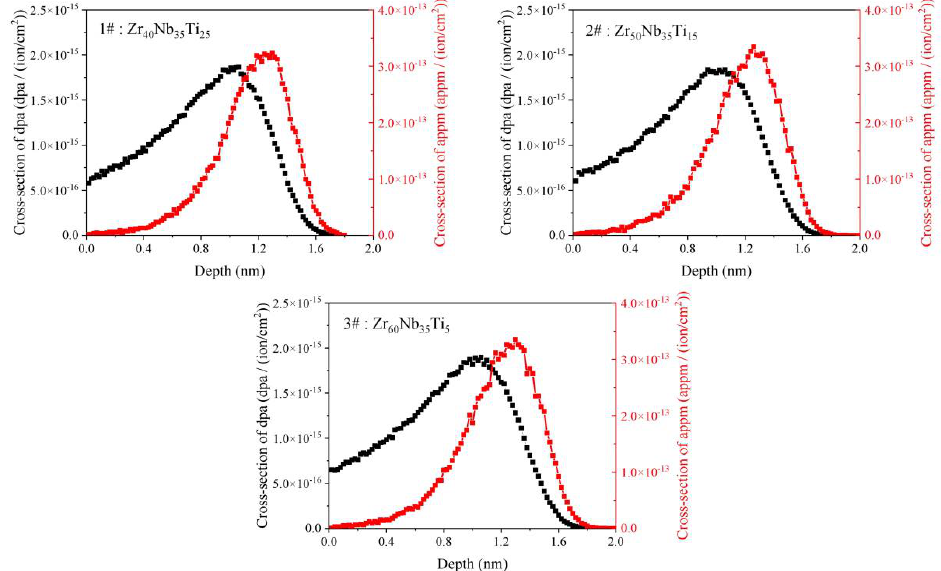
Figure 1. The depth profiles of damage (black line) and Fe ion concentration (red line) for the samples 1#, 2#, and 3# calculated by SRIM 2008.